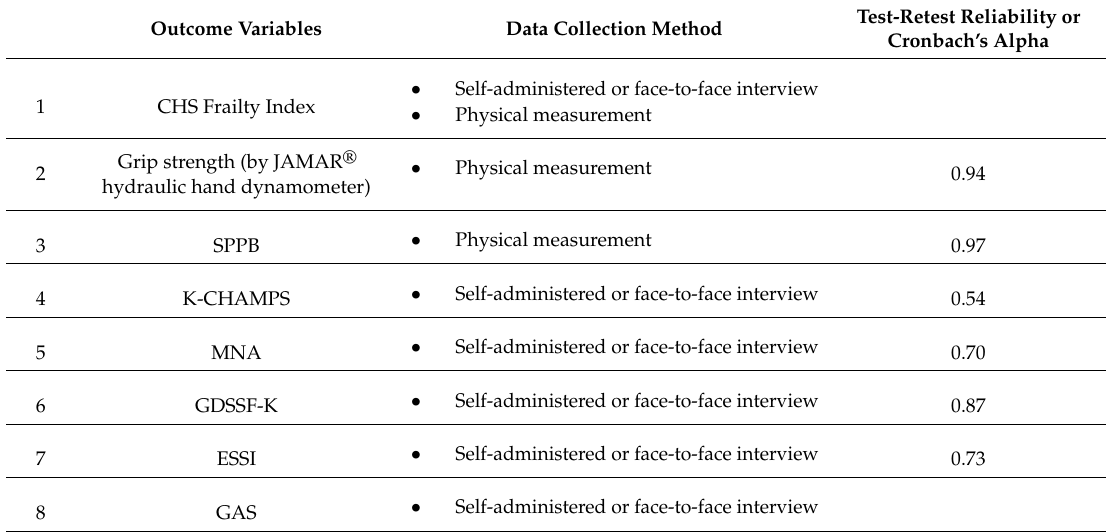
Table A2. Outcome measurements of this